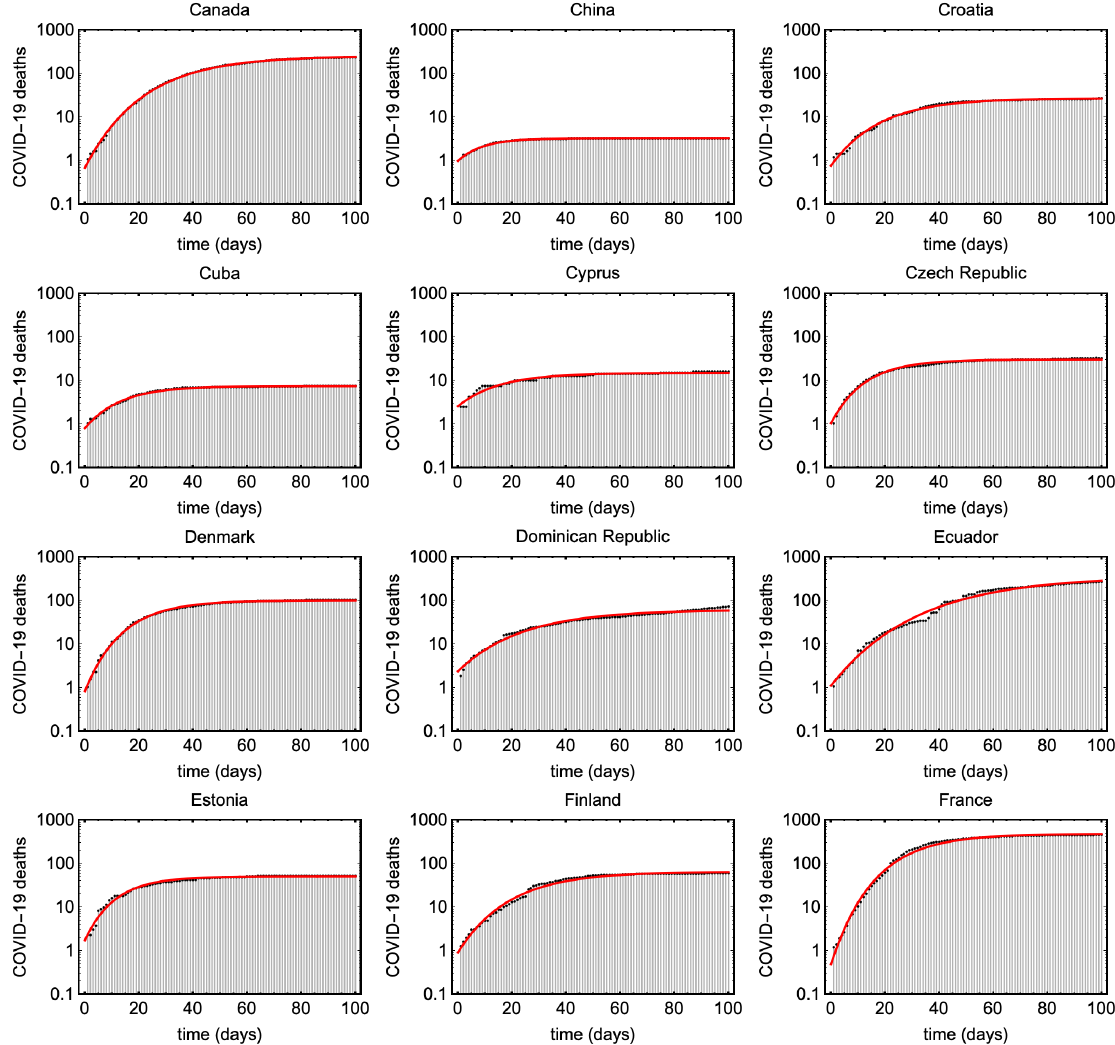
Figure A3. Shows cumulative COVID19 deaths (black) and the estimated Gompertz curves for different countries